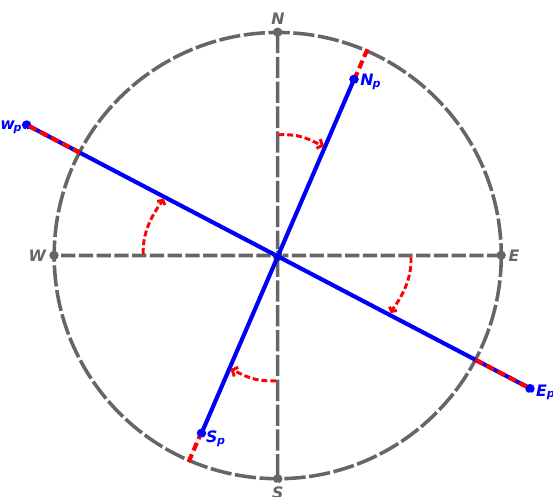
Figure 1. Graphical sketch of a projected discrete indicatrix. N p , E p , S p and W p represent the end points of the discrete indicatrix stems after projection; N , E and S , W represent their positioning if no distortion took place. The red segments and the red arc represent the distance and angular distortions computed.